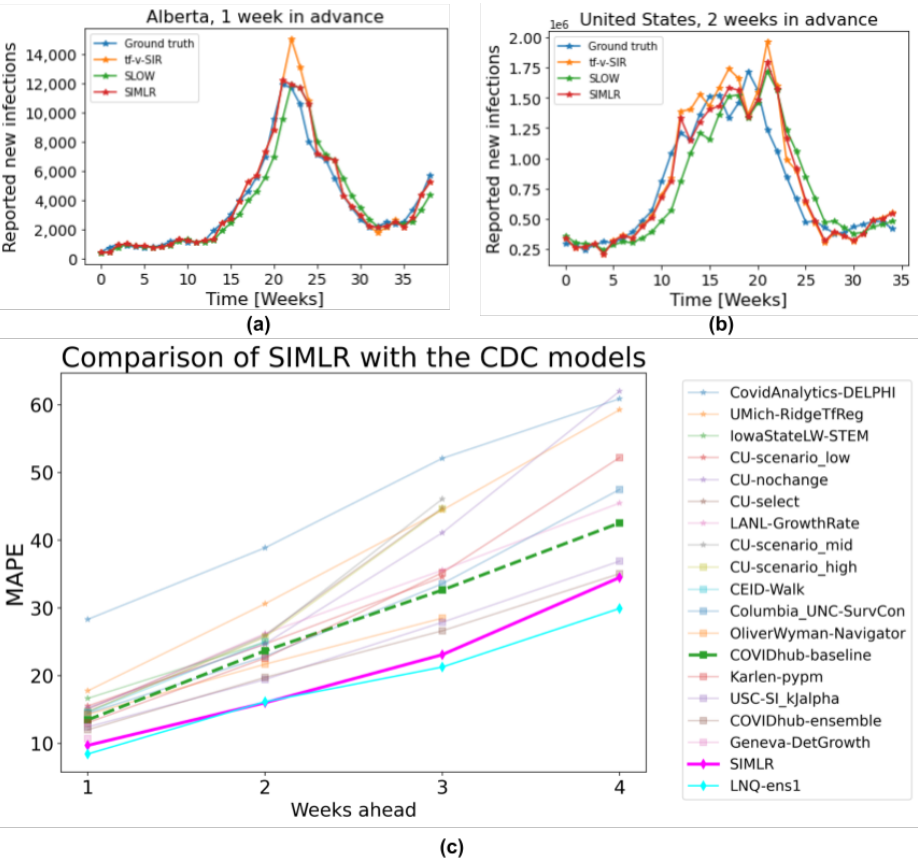
Figure 8. ( a ) 1-week forecasts SIMLR, tf-v-SIR, and SLOW, for Alberta, Canada. ( b ) 2-week forecasts, of the same models, for US data. ( c ) Comparison of SIMLR versus models submitted to the CDC (on US